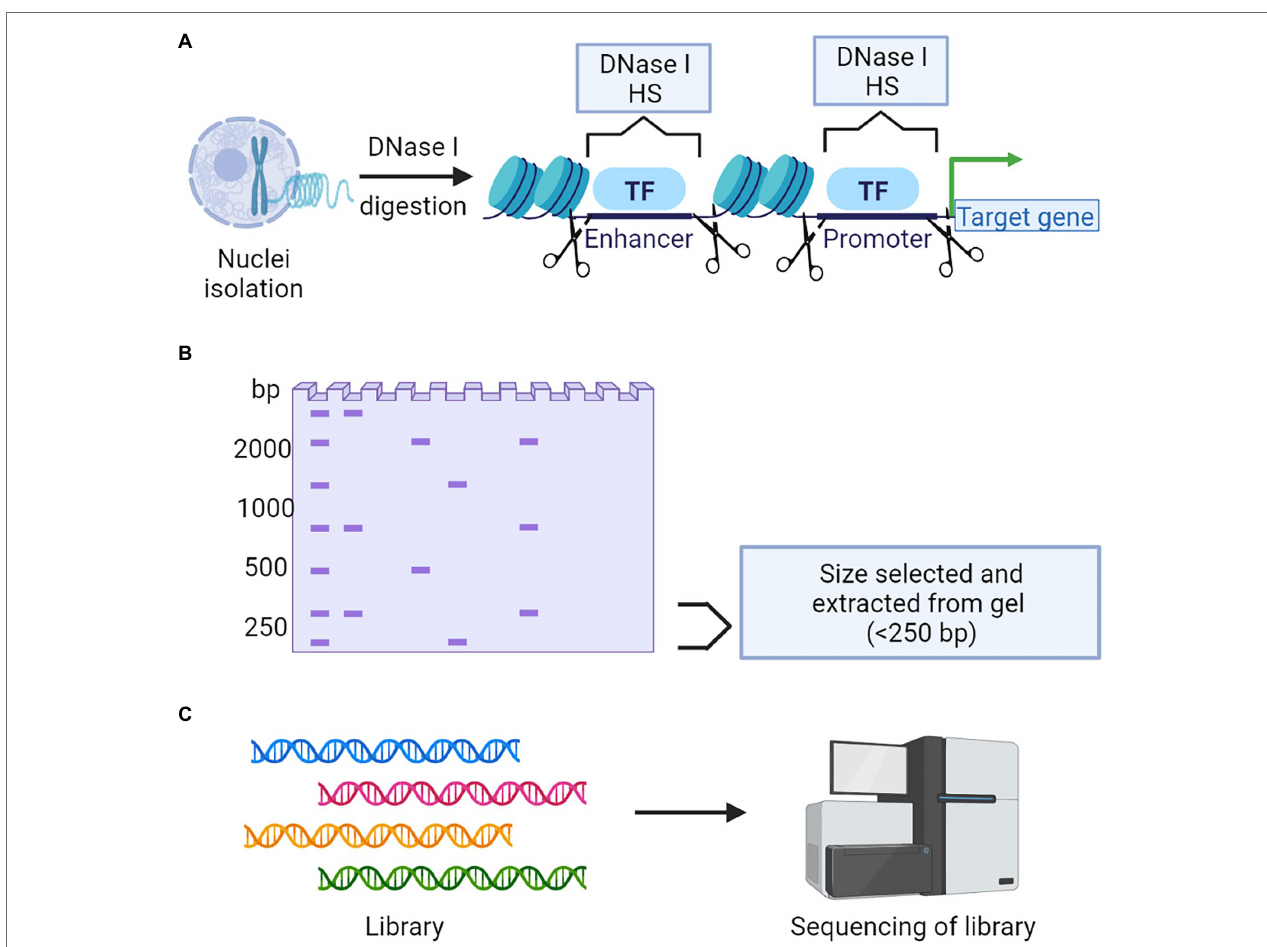
FIGURE 6 | A schematic representation of DNase Seq to determine chromatin accessibility. (A) Nuclei isolation followed by DNase I digestion is a critical step to collect the chromatin. (B) Targeted fragments will be selected and isolated from gel. (C) Library construction followed by next-generation sequencing and data